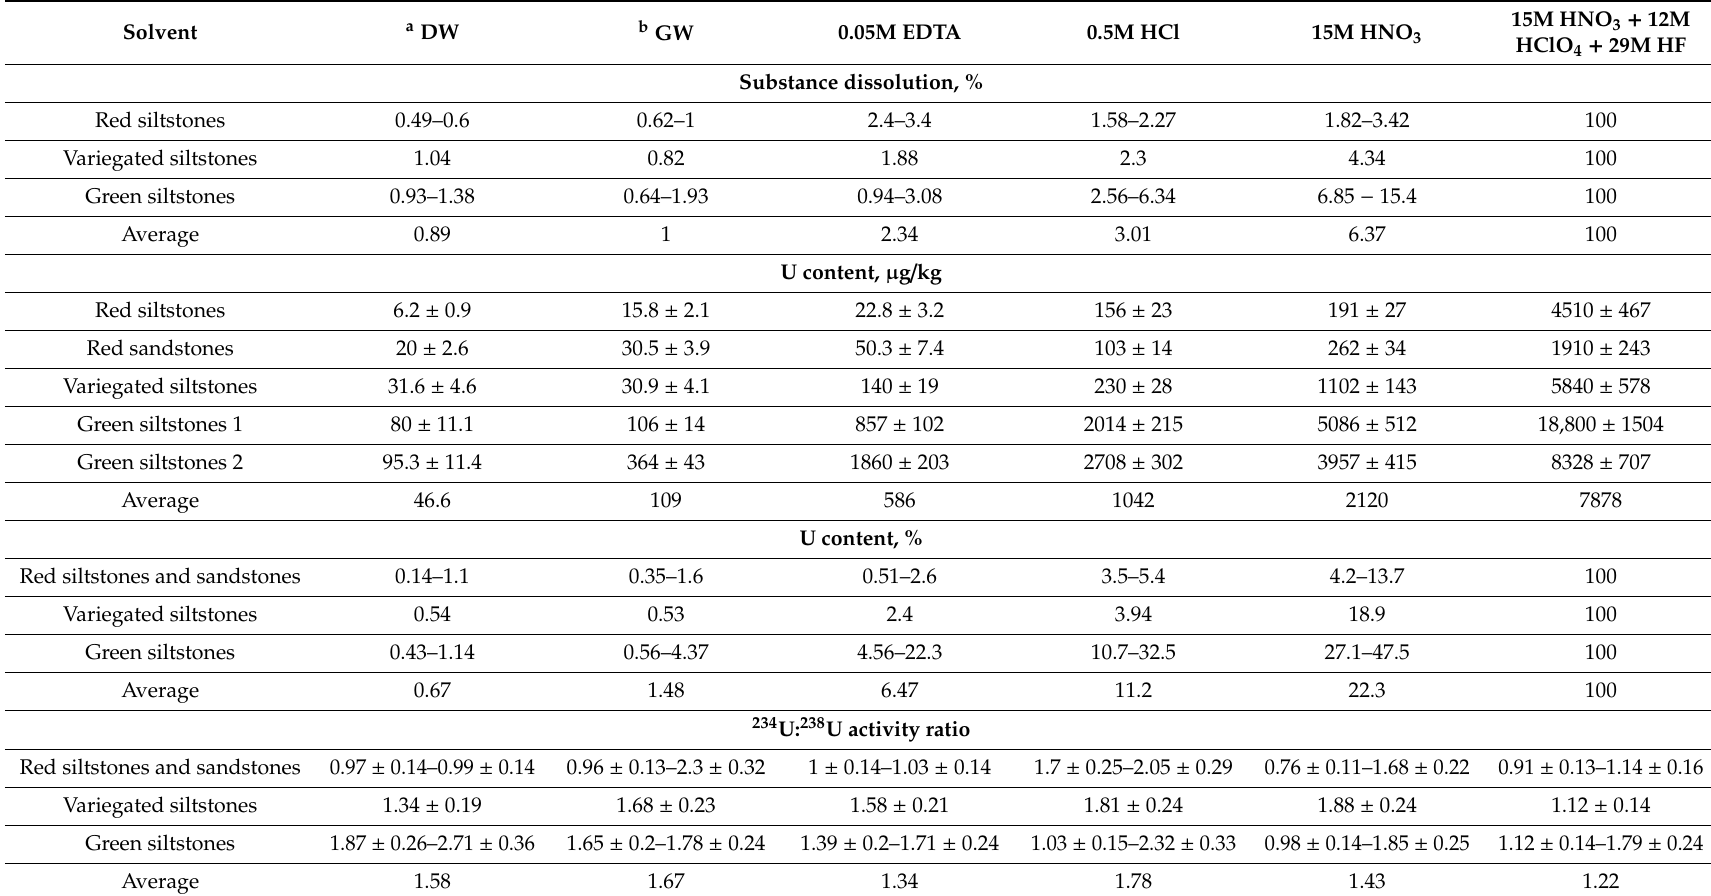
Table 2. Distribution of uranium and measured 234 U: 238 U activity ratios in extracted